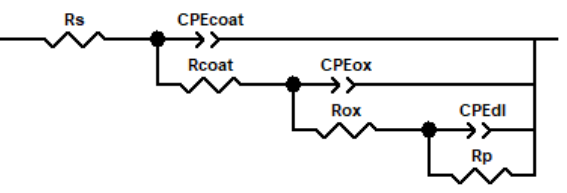
Figure 3. Equivalent electrical circuit and its passive elements used to fit the curves obtained from the electrochemical impedance tests.